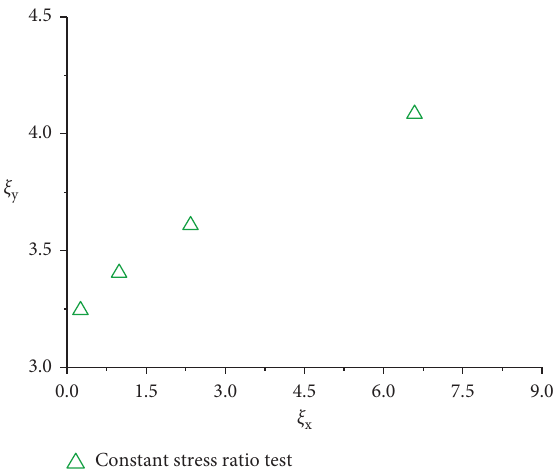
Figure 12: CR test of granite rockfill materials [16] ( σ 1/ σ 3 � 1.5, 2.0, 2.5, and 3.5).